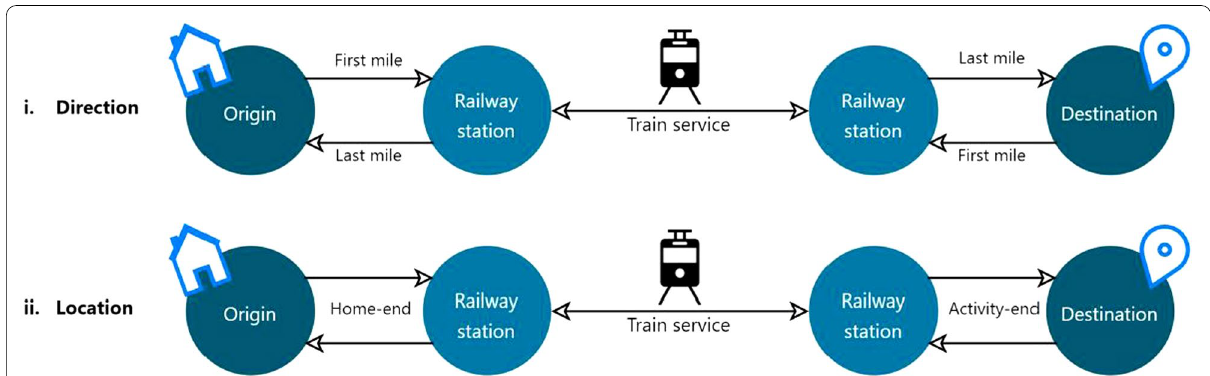
Fig. 1 Trips of a multimodal journey described in terms of (i) direction and (ii)